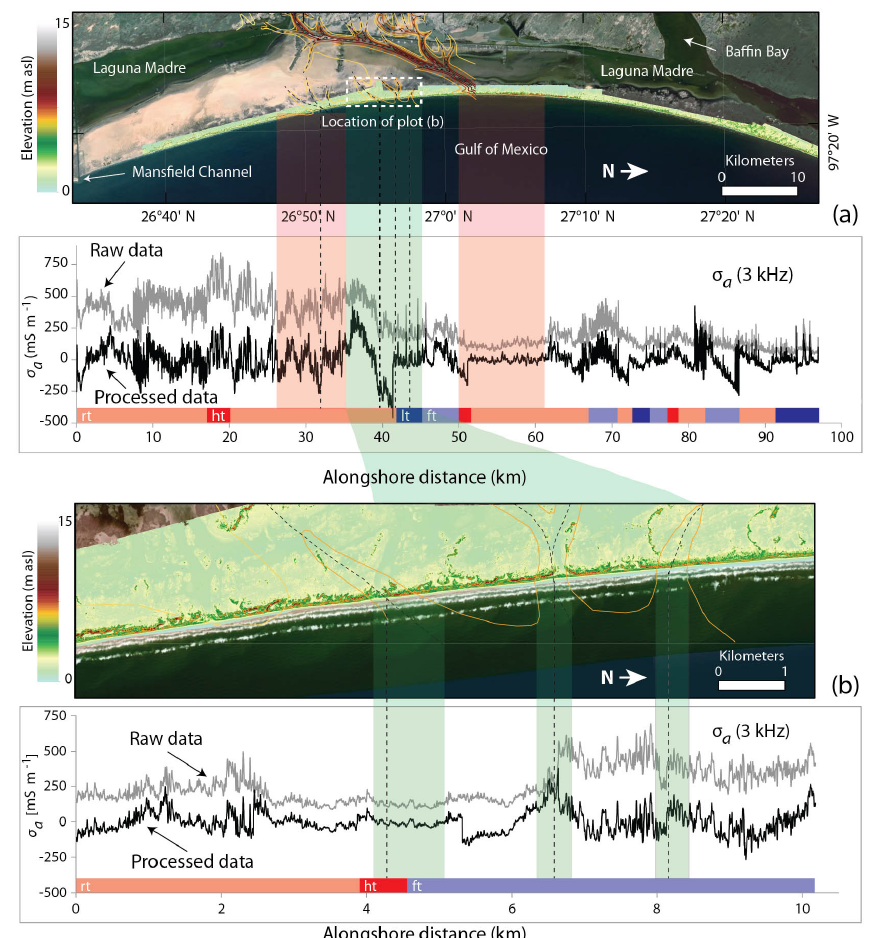
Figure 2. The 100km (a) and 10km (b) alongshore EMI surveys showing DEMs of the study area and previously identified paleo-channel region by Fisk (1959). Channels are highlighted in red and green, where the green region indicates the location of the 10km survey. The 25ft (7.6m) contour intervals are highlighted with depths increasing from yellow to red and the center of the channels are represented by the black-dotted lines. For each survey, raw σ a and zero-mean drift-corrected EMI responses are shown in gray and black, respectively. Tidal conditions during each EMI acquisition segment are shown below each panel. Low (lt) and falling tides (ft) are indicated by blue and light blue shades, respectively. High (ht) and rising tides (rt) are highlighted in red and light red,